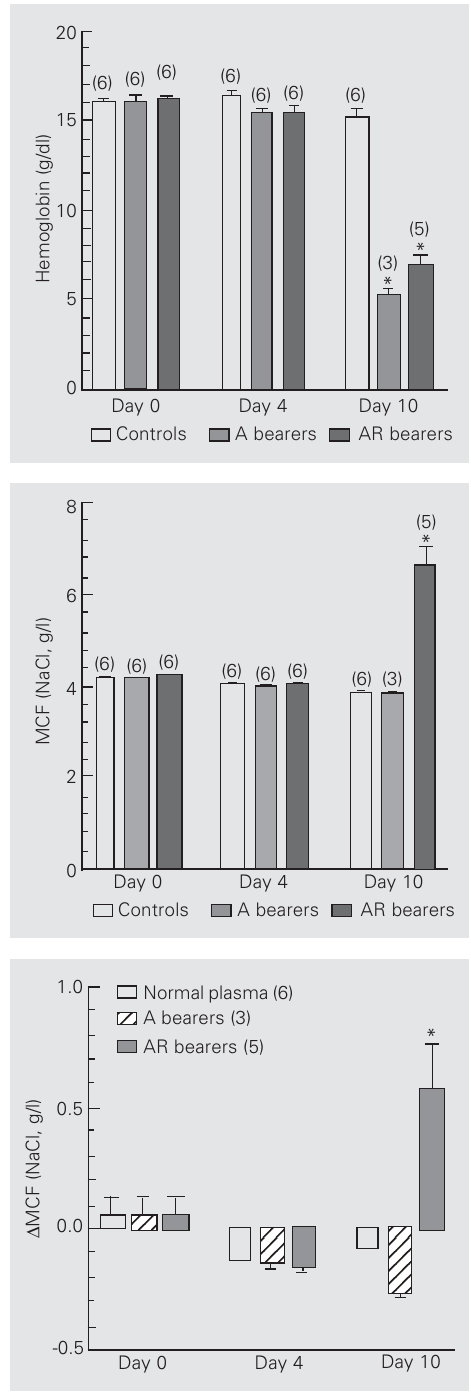
Figure 3. Changes in osmotic fragility induced in normal donor RBC by incubation (30 min at 37 º C) with plasma obtained from controls, Walker 256 (W256) A tumor bearers and W256 AR tu- mor bearers at different inter- vals after tumor inoculation. Data are reported as means ± SEM. The number of experi- ments is given in parentheses. MCF = mean corpuscular fragil- ity. *P < 0.05 compared to con- trol on day 10 (ANOVA followed by the post hoc Dunnett